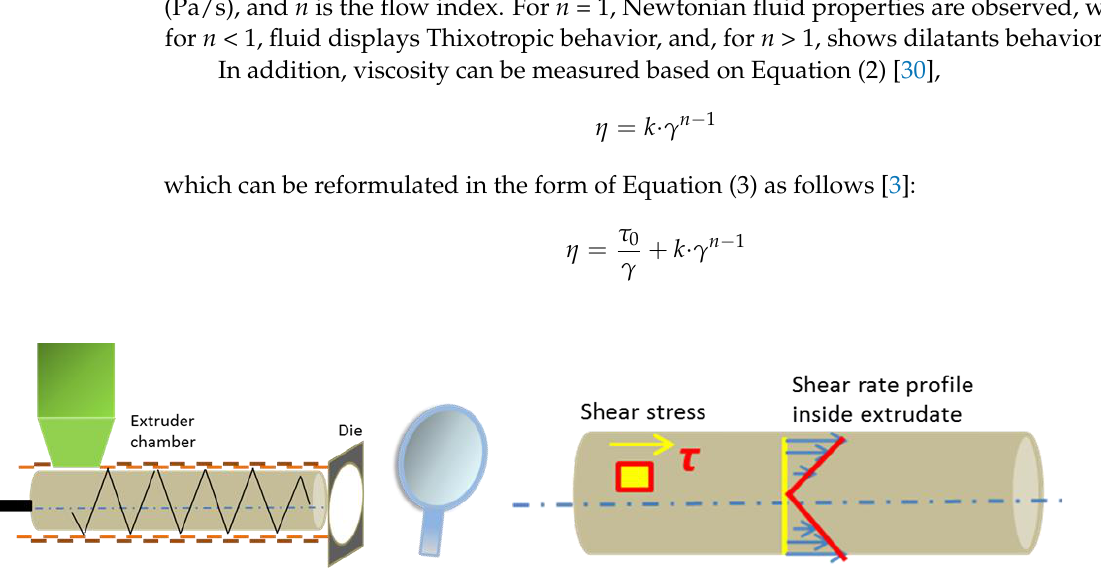
Figure 1. ( A ) Schematic illustration of zeolite shaping using extrusion technique, ( B ) Commercial